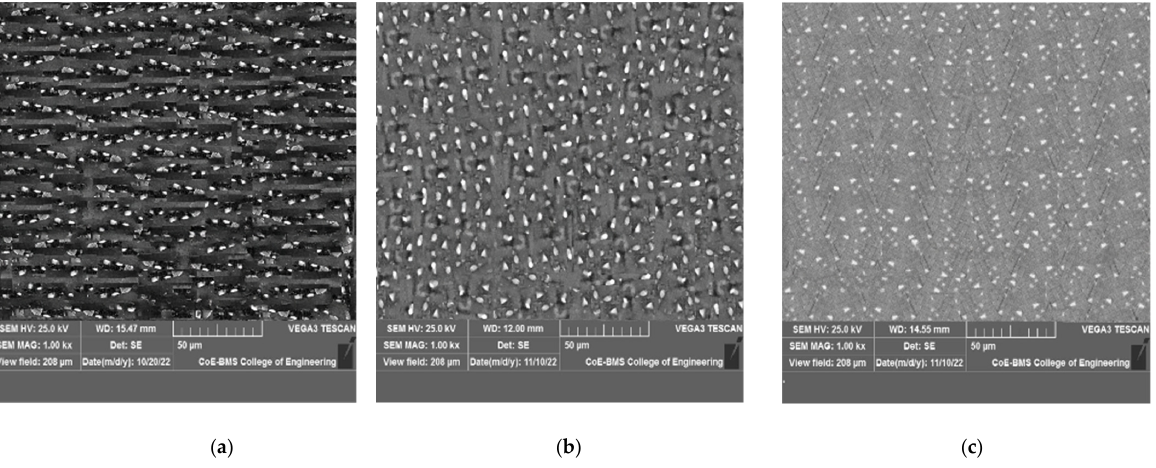
Figure 4. SEM images of a FSPed AA7075/ TiO 2 sample prepared at ( a ) 800 rpm and 35 mm/min, ( b ) 1000 rpm and 35 mm/min, and ( c ) 1000 rpm and 45 mm/min.